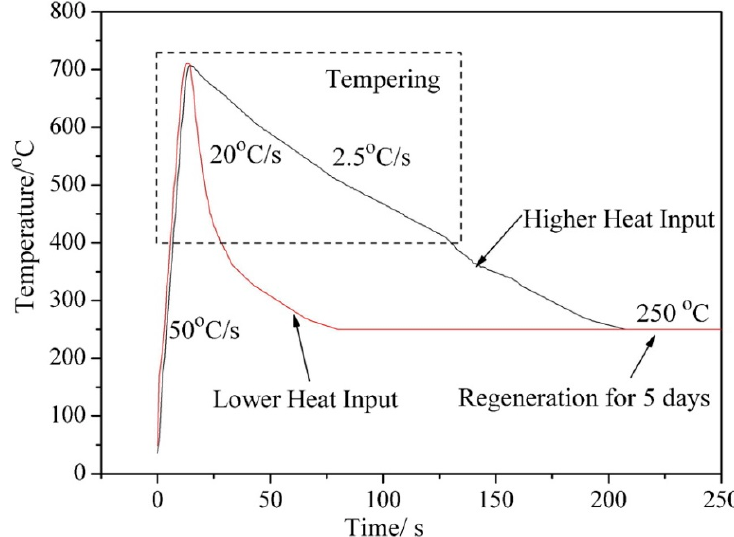
Figure 4. Thermal cycles simulation of the low-temperature heat-affected zone for low- and high-energy welding processes [21].